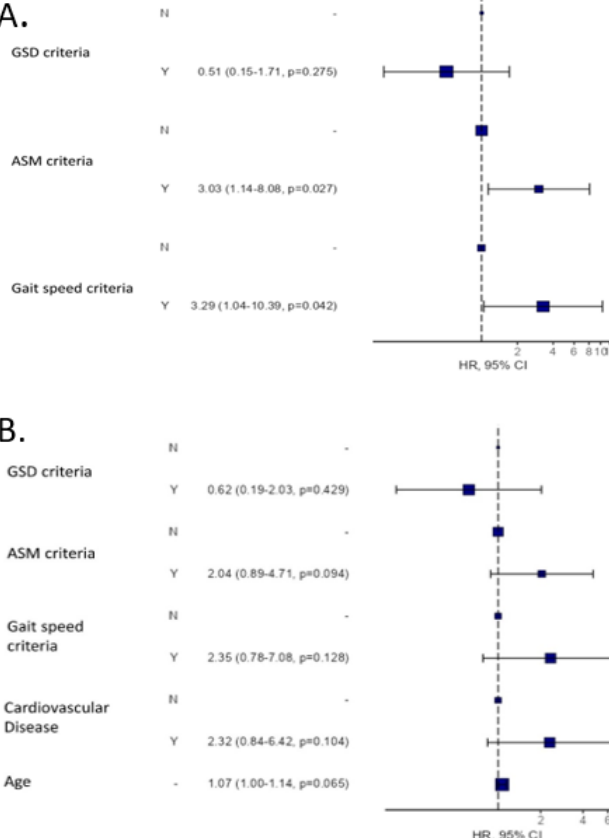
( A ) Univariate analysis. ( B ) Multivariate analysis including the EGWSOP2 criteria, age and cardiovascular disease.